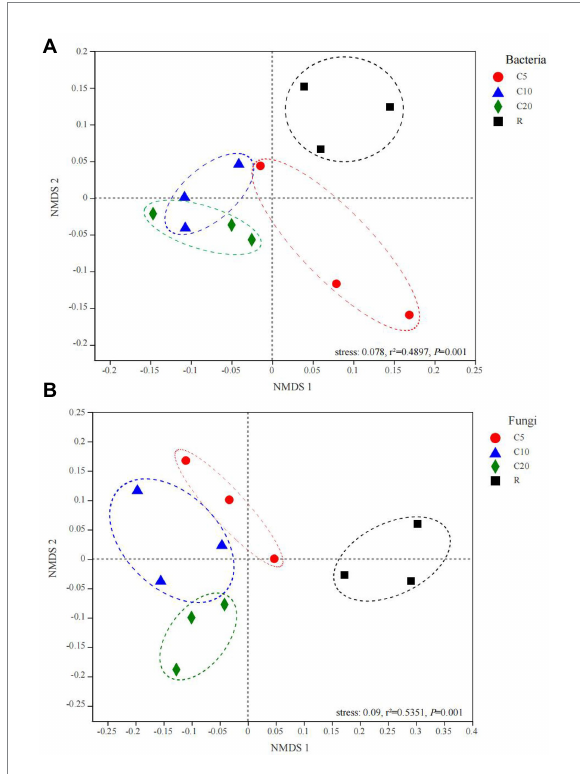
FIGURE 1 NMDS analysis among soil bacterial (A) and fungal (B) samples of different treatments based on OTU level. The significance of differences was tested using Adonis (999 permutations). C5, C10, and C20 represent soybean continuous cropping treatments for 5, 10, and 20 years, respectively, and R represents soybean-corn rotational cropping